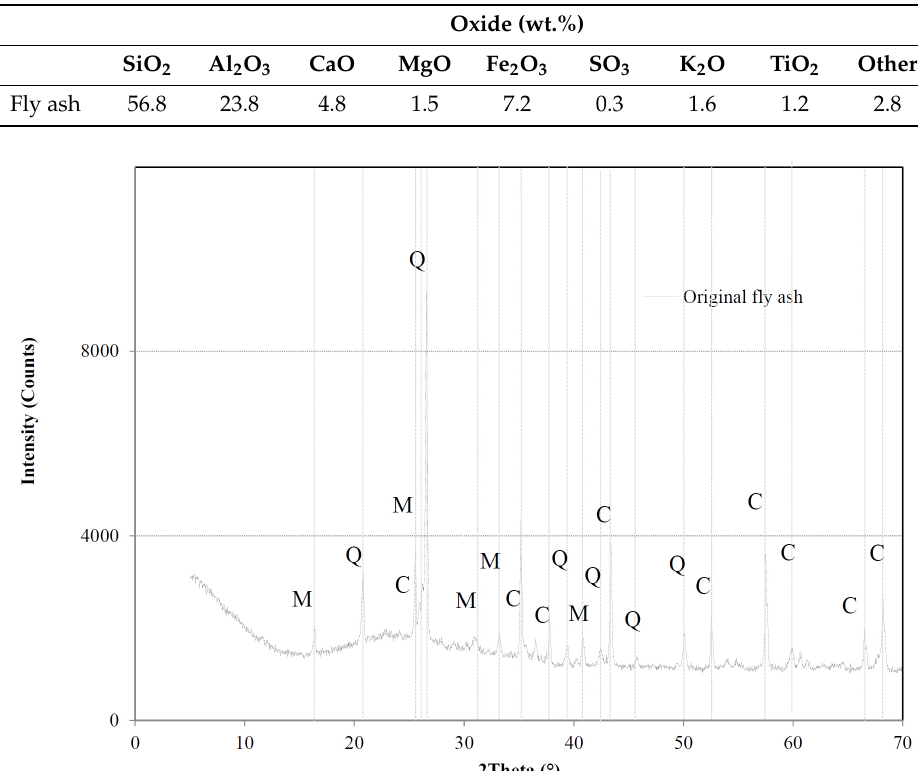
Table 1. Chemical composition of fly ash.